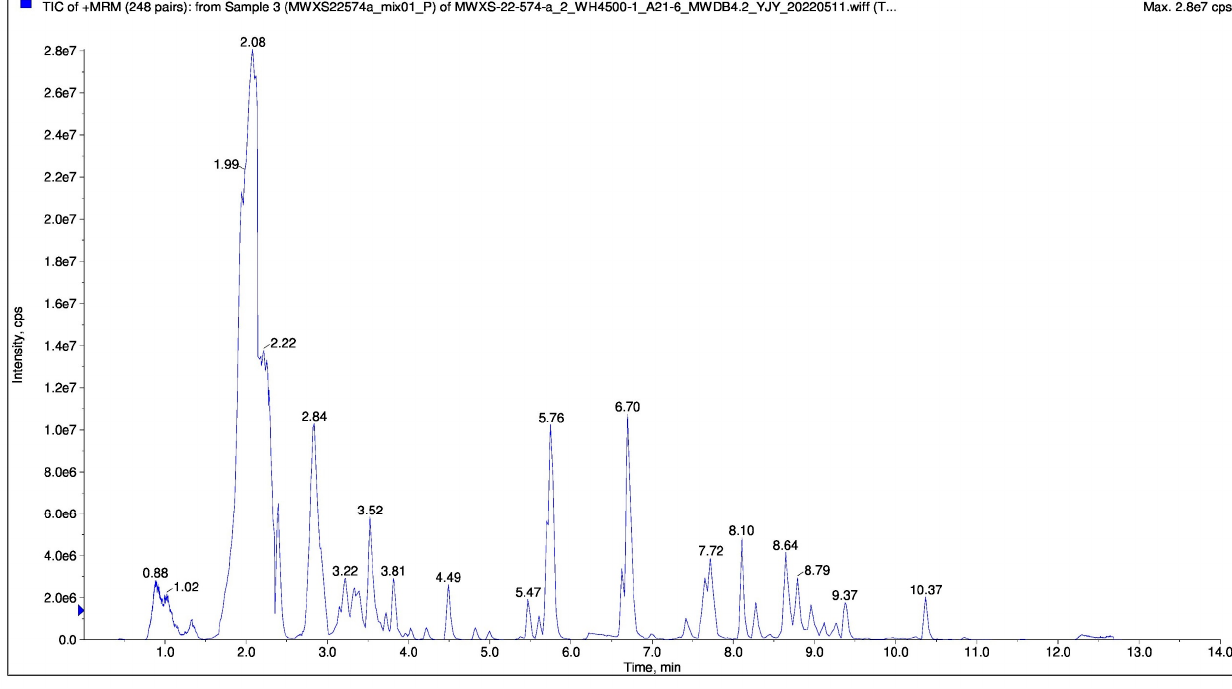
Figure 6. Total ion current diagram of mixing quality spectrum